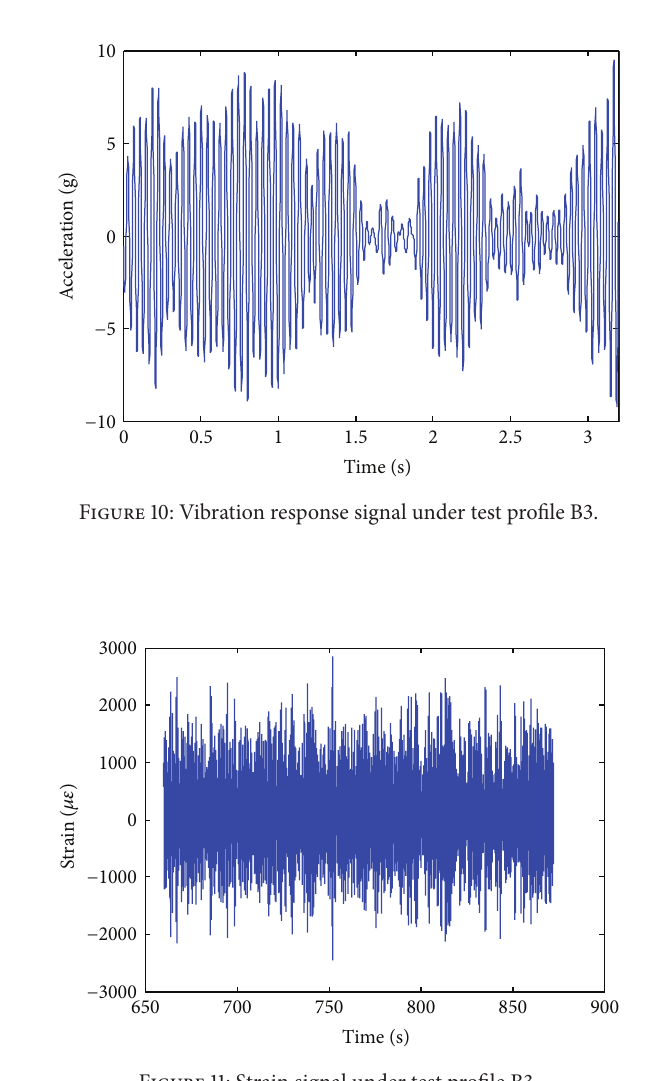
Figure 11: Strain signal under test profile